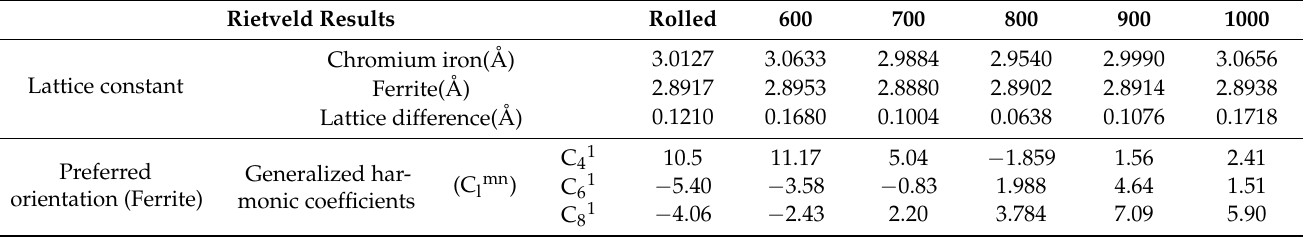
Table 2. Refined lattice constant and preferred orientation index for generalized harmonic index